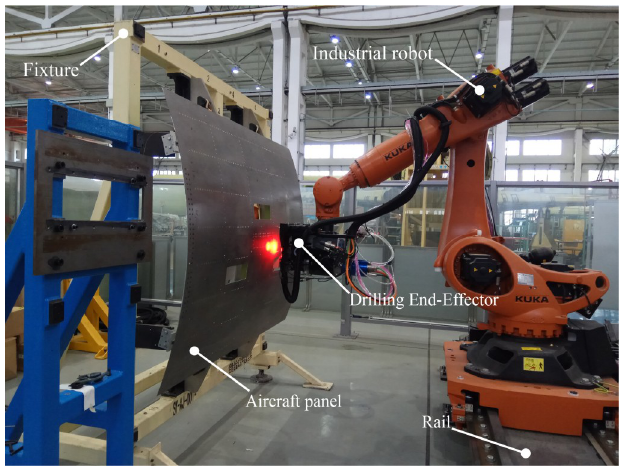
Figure 1. The robotic drilling system.